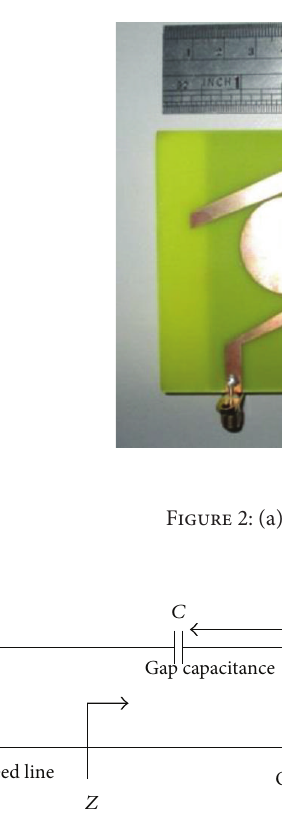
situated at the top and bottom side of the antenna. A sharp edge banding after the feed line is performed to have better resonance at the first resonance